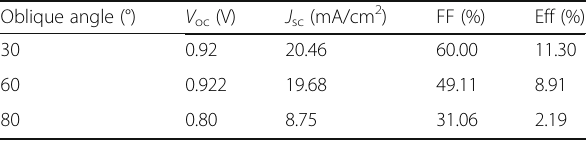
Table 1 Parameters of perovskite MAPbI 3 film on oblique ITO layer with various oblique angles Oblique angle (°)